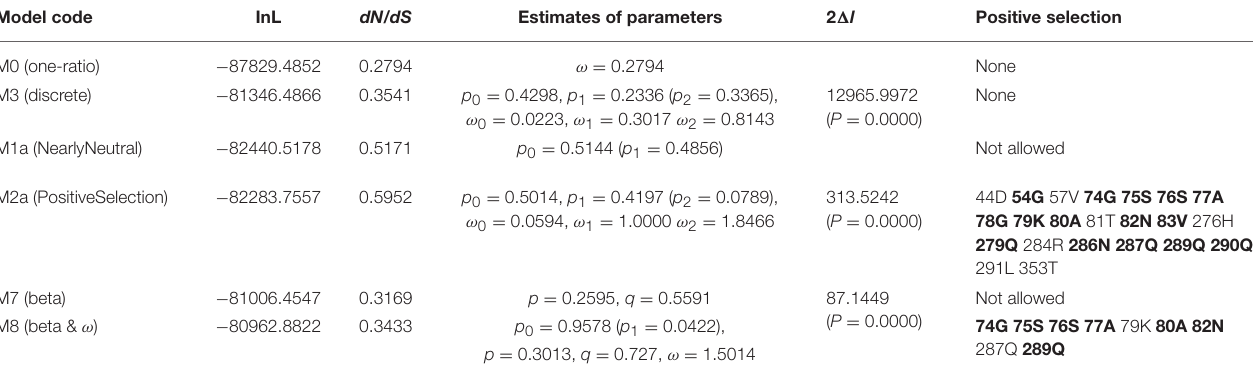
TABLE 1 | Likelihood values and parameter estimates for AP2 group genes sequences in Spermatophyte. Model